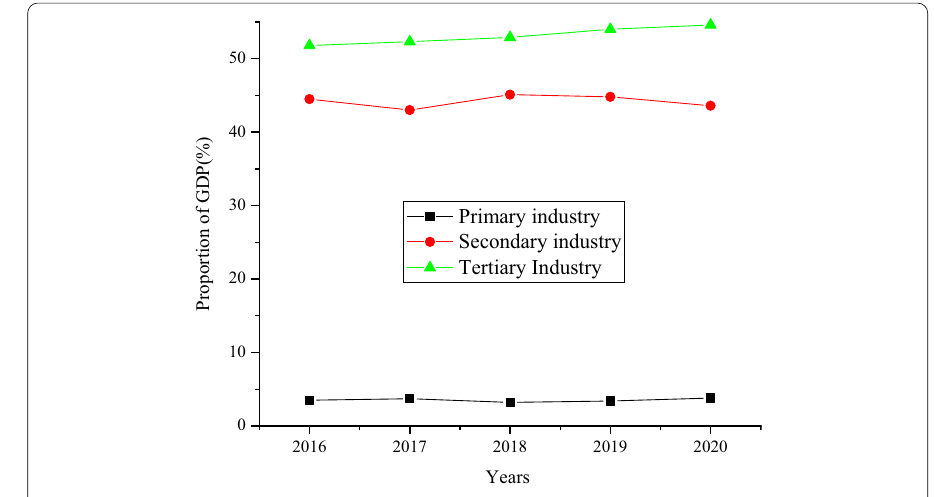
Fig. 12 Proportion of three industries to GDP